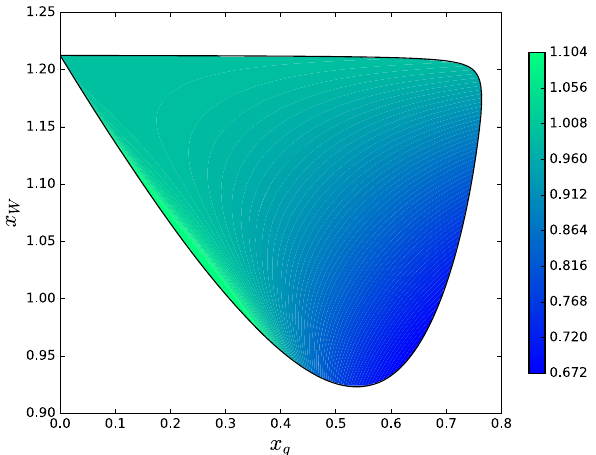
Fig. 4 Dalitz plot for t → bW + g where the gluon is showing the ratio of the leading-order matrix element result over the dipole-shower approximation. The energy fractions of the gluon and W + boson are x g = 2 E g / m top and x W = 2 E W / m top , respectively